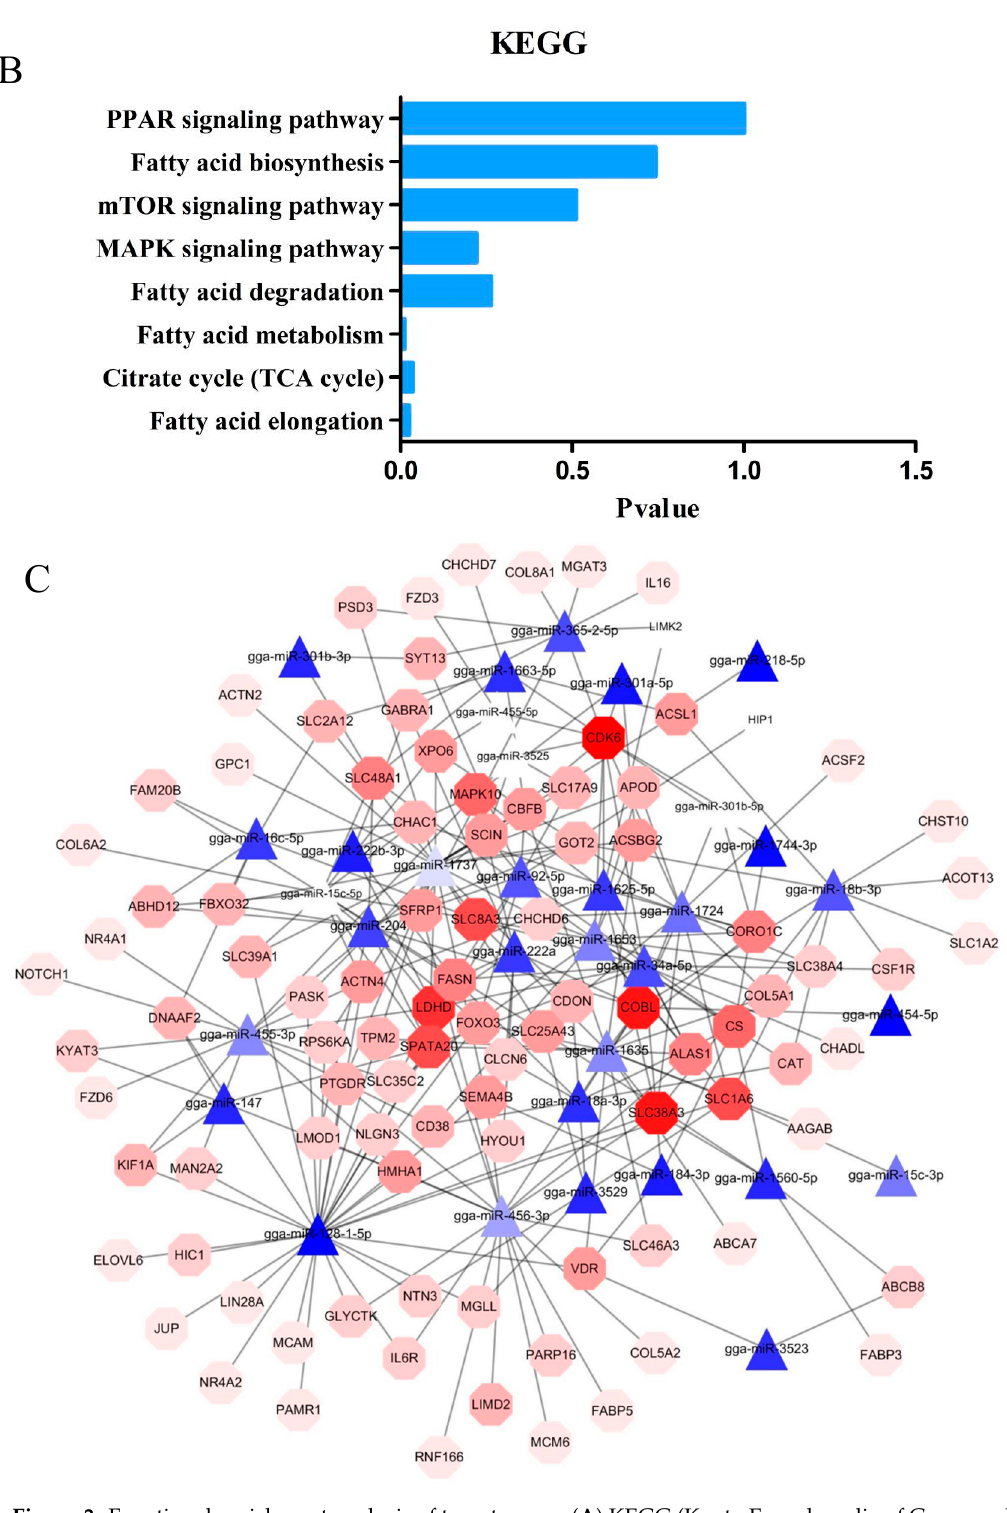
Figure 3. Functional enrichment analysis of target genes. ( A ) KEGG (Kyoto Encyclopedia of Genes and Genomes) analysis on targets of differentially expressed miRNAs. ( B ) Identified KEGG pathways related to lipid metabolism. ( C ) Interactive network for differentially expressed miRNAs and their targets.